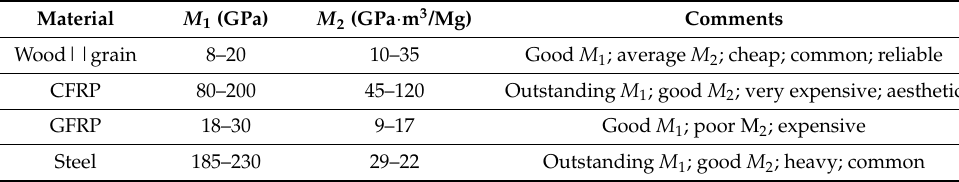
Table 16. Selected materials from Ashby chart.